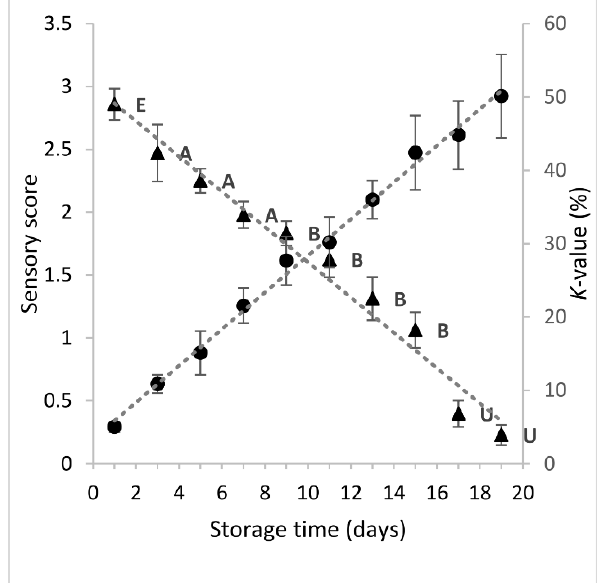
Figure 1. Changes in sensory score (- ▲ -) and K -value (- ● -) of sea bream stored in ice. Each point represent the mean value of six replicate measurements (three fish samples x two storage experiments at each sampling point). Error bars denote standard deviation. The labels of sensory scores denote the freshness category according to EU grading system.